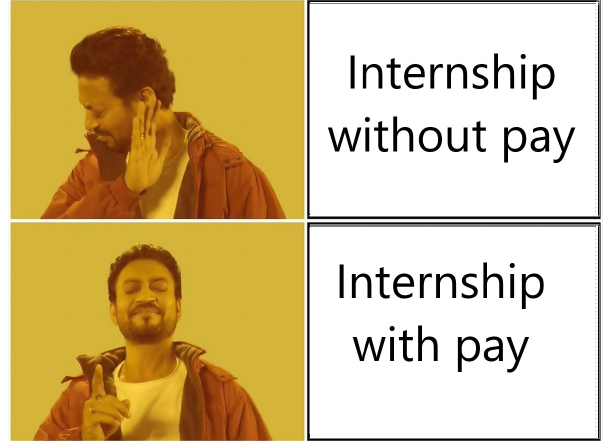
Figure 1. The sample of one of the popular copies of the ‘Drake’ meme on social media